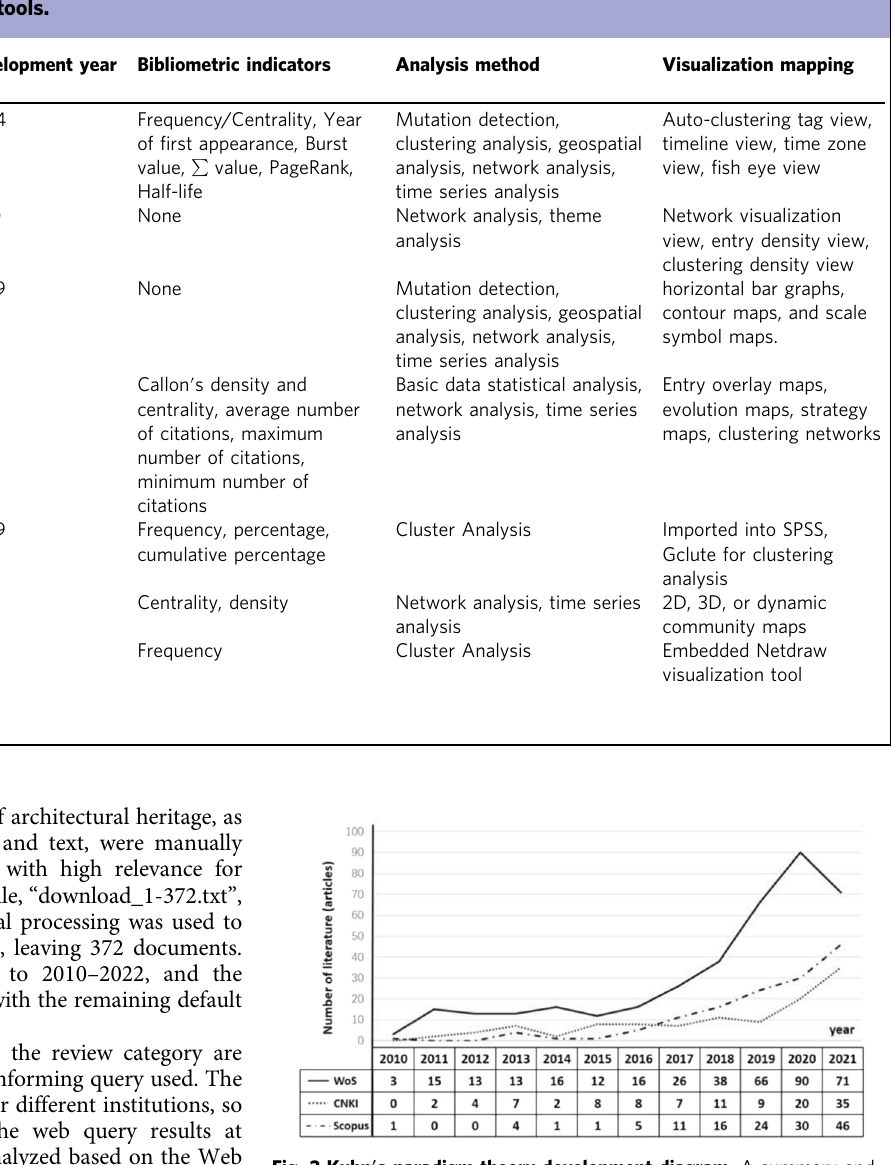
Fig. 2 Kuhn ′ s paradigm theory development diagram. A summary and elaboration of the development of Kuhn ′ s paradigm